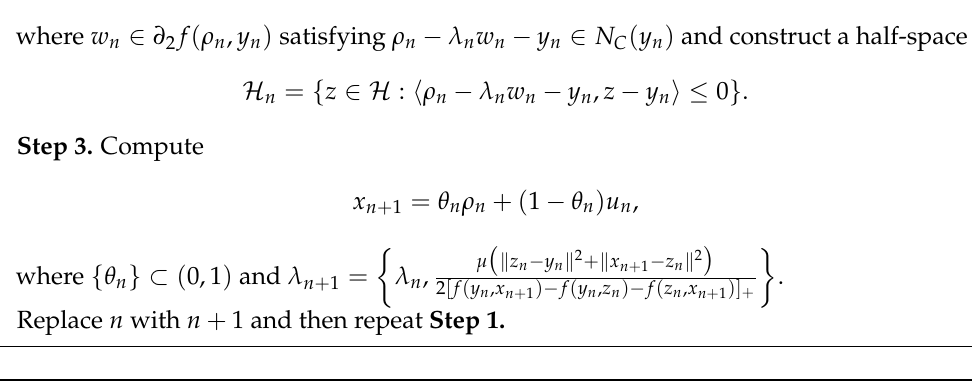
Algorithm 3 Modified inertial subgradient extragradient Mann Algorithm